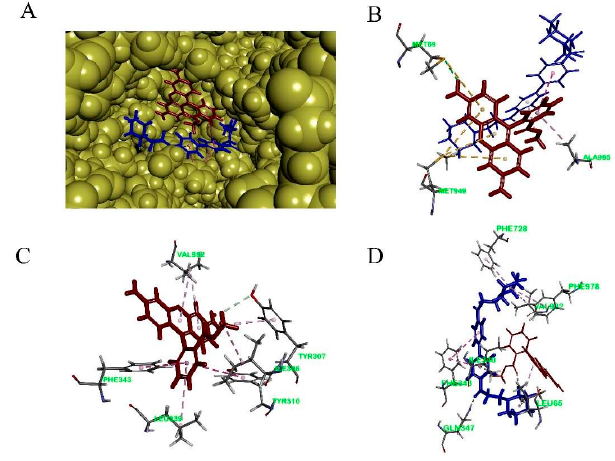
Figure 7. The binding mode of Rho123 to human P-glycoprotein. ( A ): The co-existence of DL0410 and Rho123 on the drug binding pocket of P-gp; ( B ) The 3D interaction model of Rho123 with the drug binding pocket of P-gp in the presence of DL0410; ( C ) The 3D interaction model of Rho123 with the drug binding pocket of P-gp in the absence of DL0410; ( D ) The 3D interaction model of DL0410 with the drug binding pocket of P-gp in the presence of Rho123.